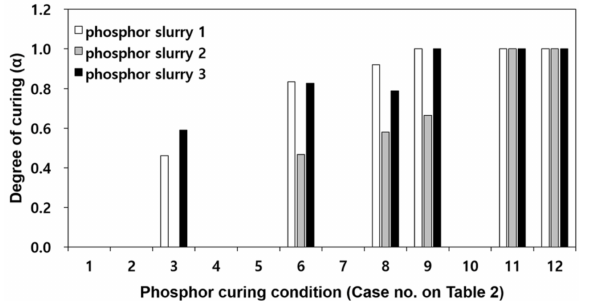
Figure 2. Comparison of the degree of curing of phosphor film per phosphor slurry and curing process